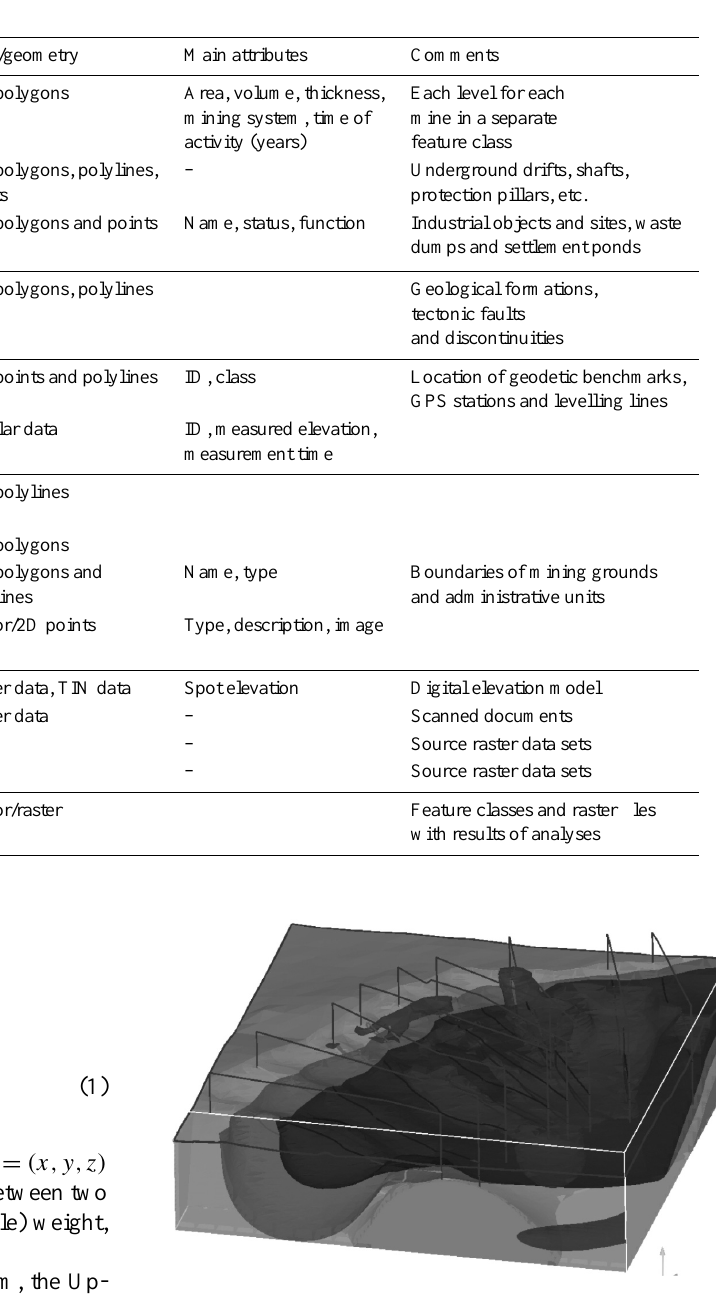
Figure 3. The three-dimensional numerical, geological model for the part of the former mining area shown with the black box in Fig. 2. tion process has been based on the comparison of the calcu- lated extent of the selected coal levels and tectonic faults with the available mine plans and geological maps. In addition, the calculated values of the slope of particular geological layers and the coal levels have been checked with the available doc- umentations. The methodology of the model development is shown in Fig.